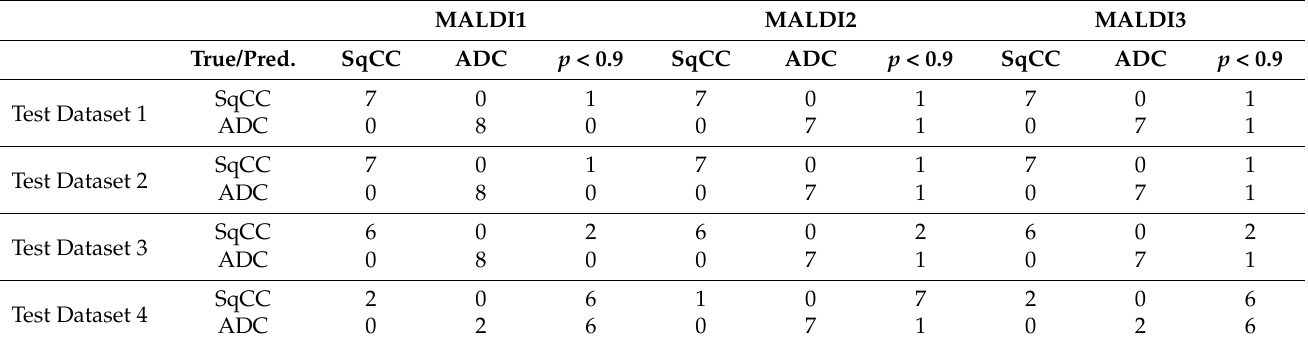
Table 5. Confusion matrices of section-wise classification of different MALDI networks for different test datasets on section level (Pred. = Prediction, quality control with p = 0.9 ). MALDI1 MALDI2 MALDI3